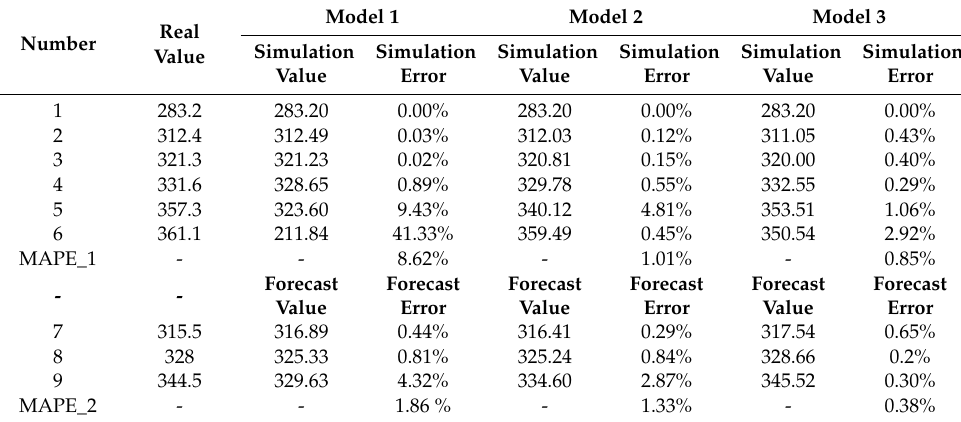
Table 6. Comparison table of the three prediction